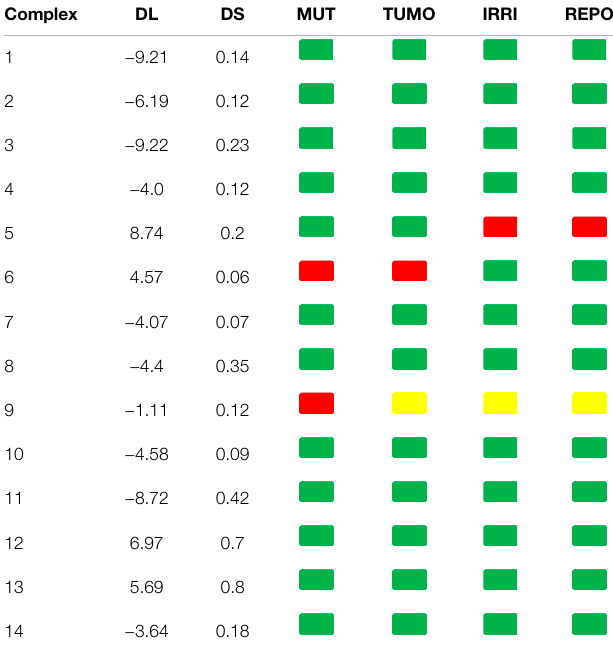
TABLE 5 | DL: drug-likeliness, DS: drug score, MUT: mutagenicity, TUMO: tumorigenicity, IRRI: irritant effect, and REPO: reproductive effect for 14 multikinase inhibitors. Green color indicates a low toxic potential, yellow color means mild toxicity, and red color indicates a high probability of toxicity. Complex DL